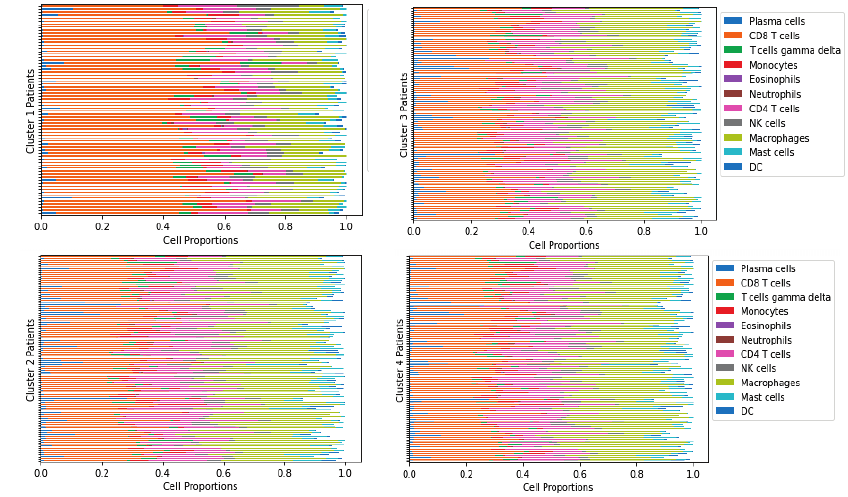
Figure 2. Immune cell frequencies of each